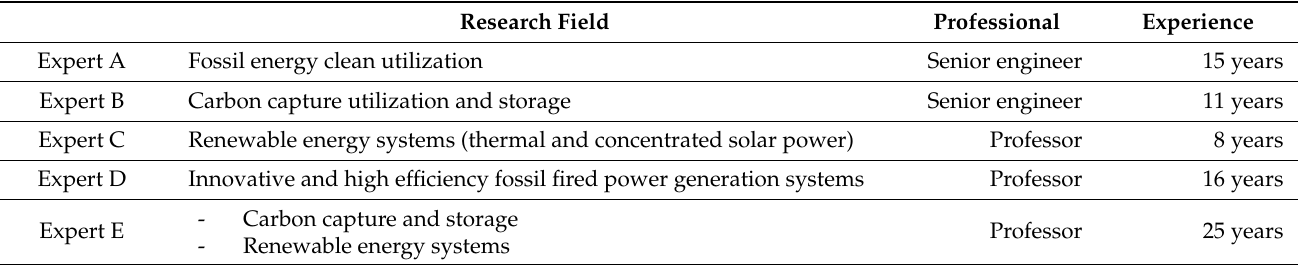
Table 2. Basic information of the experts.